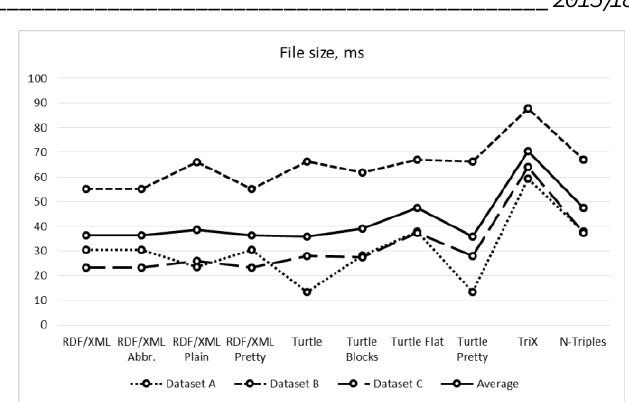
Fig. 11. File size for all